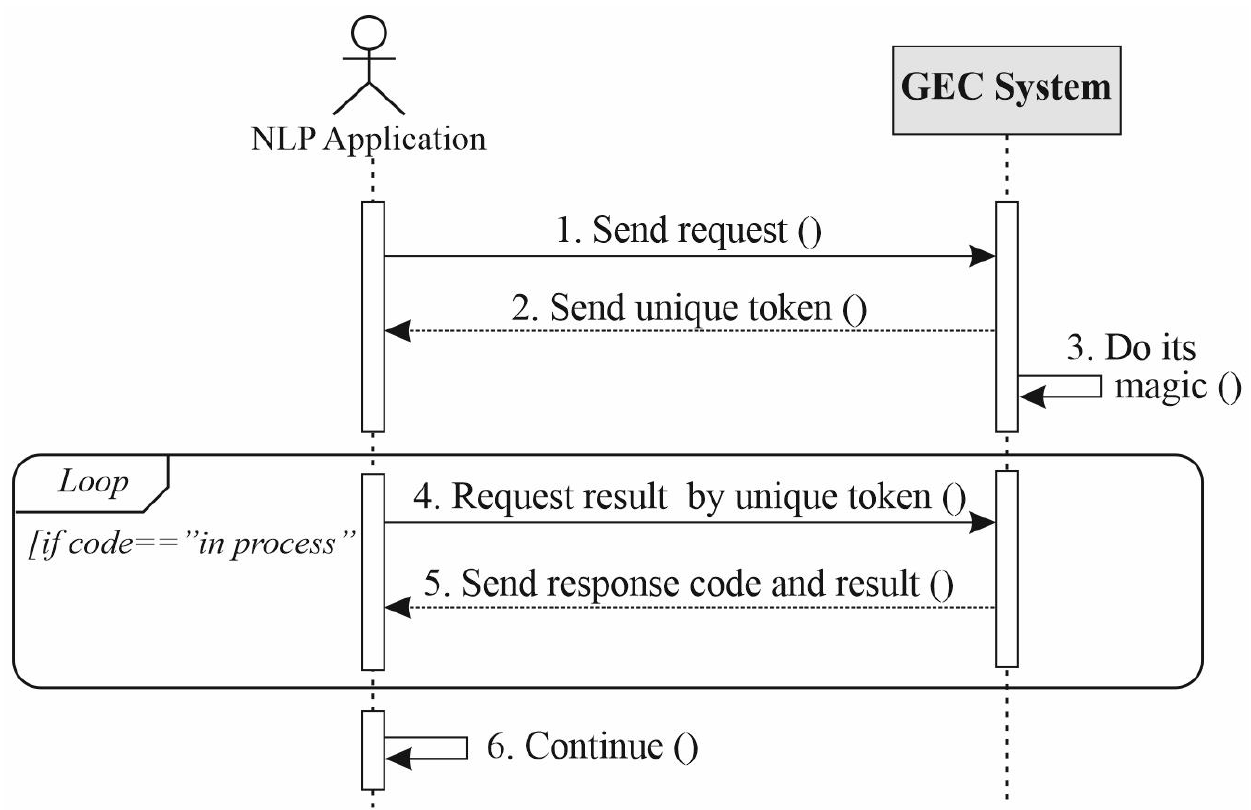
Figure 2. Sequence diagram for the second regime of the operating system.